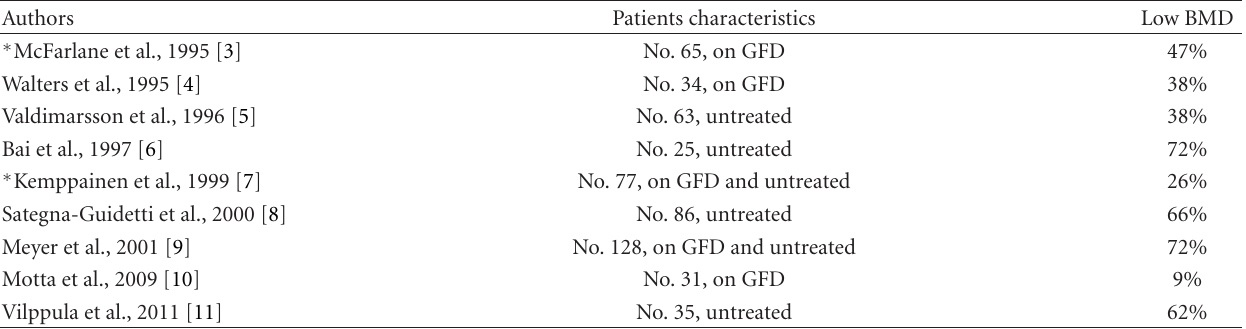
Table 1: Prevalence of low bone mineral density in patients with celiac disease as assessed by dual-energy X-ray absorptiometry scan at spine.